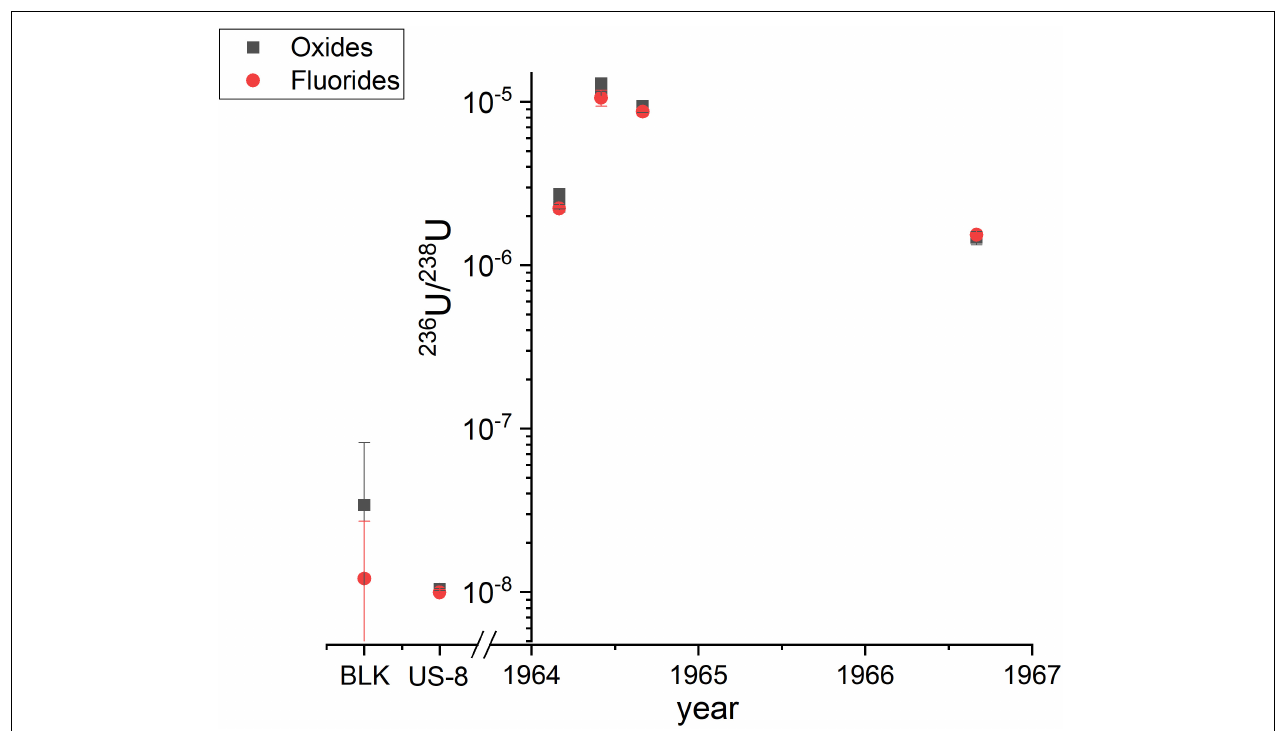
FIGURE 3 | Comparison of the 236 U/ 238 U results for air filters, either obtained by UO - (black squares) or UF 5 - (red dots) extraction. “BLK” denotes the corresponding process blank and “US-8” is a VERA in-house standard for 236 U (see main text).